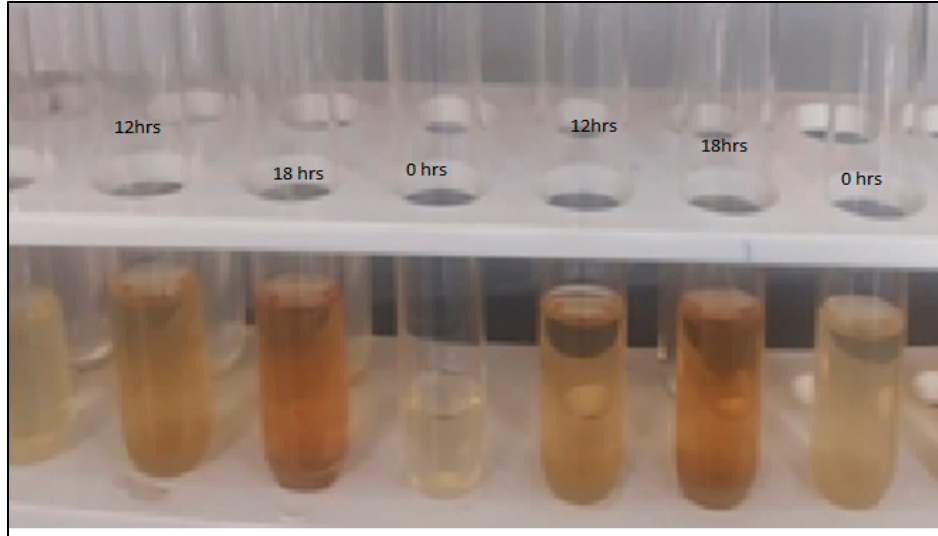
Figure 4. Incubation of silver nitrate solution with A. concinna leaf extract.